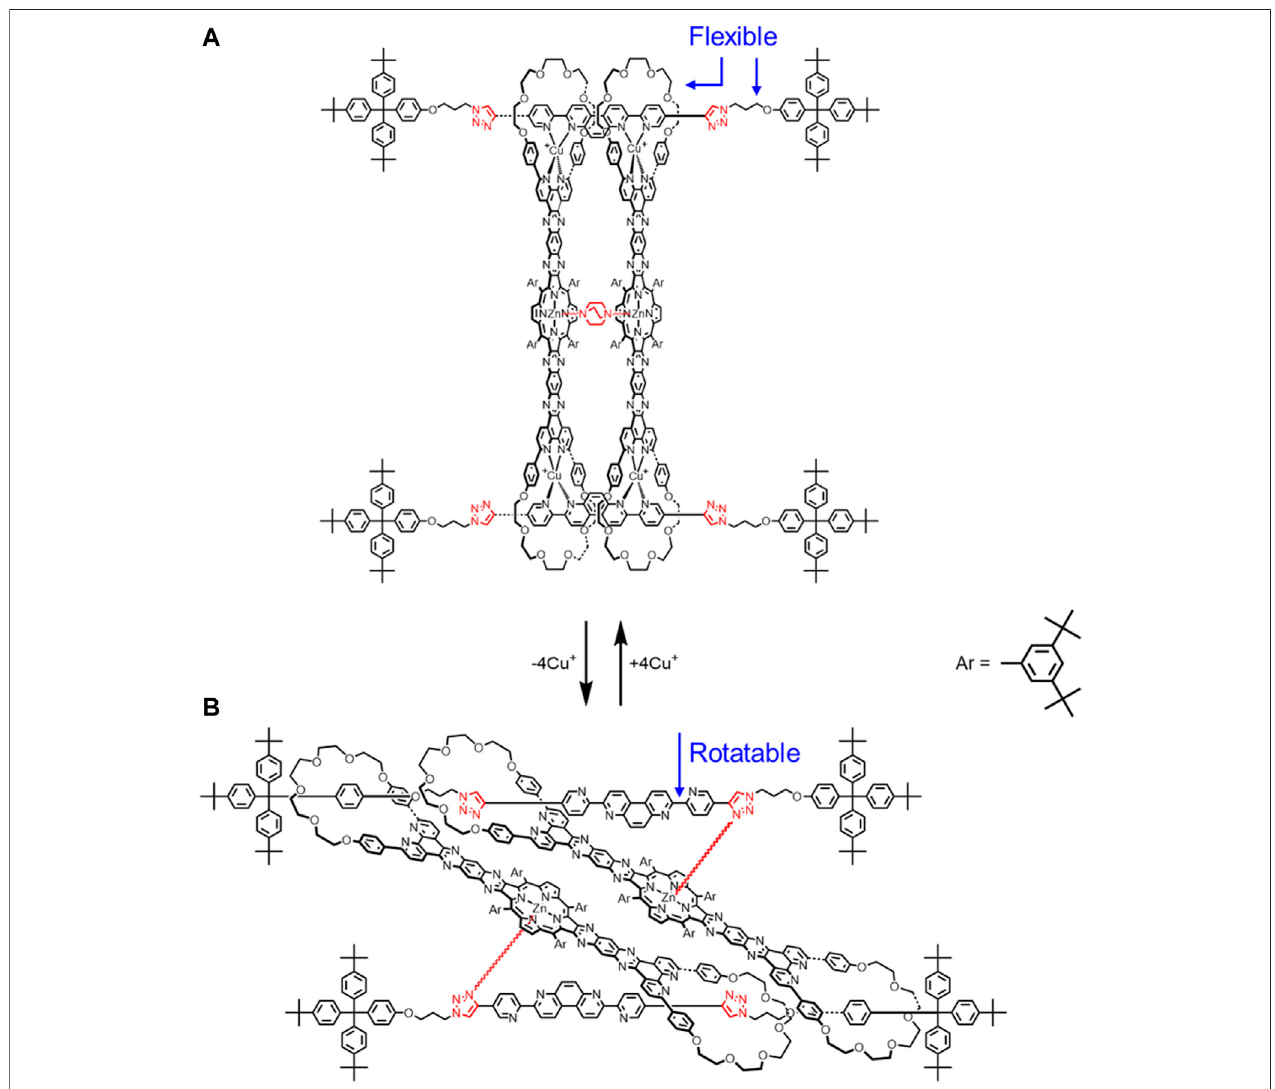
FIGURE 6 | Cyclic [4]rotaxane switch with two translational states upon (A) Cu + complexation and (B) decomplexation.